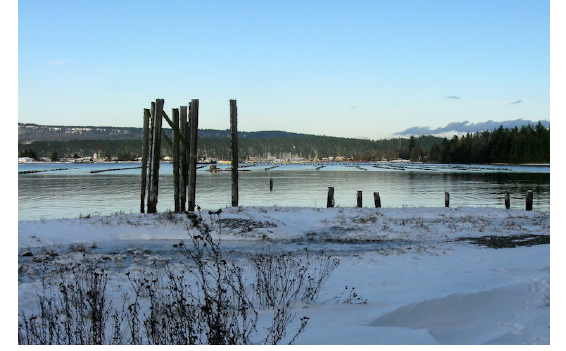
Fig. 2 . “Concern” photo representing the carrying